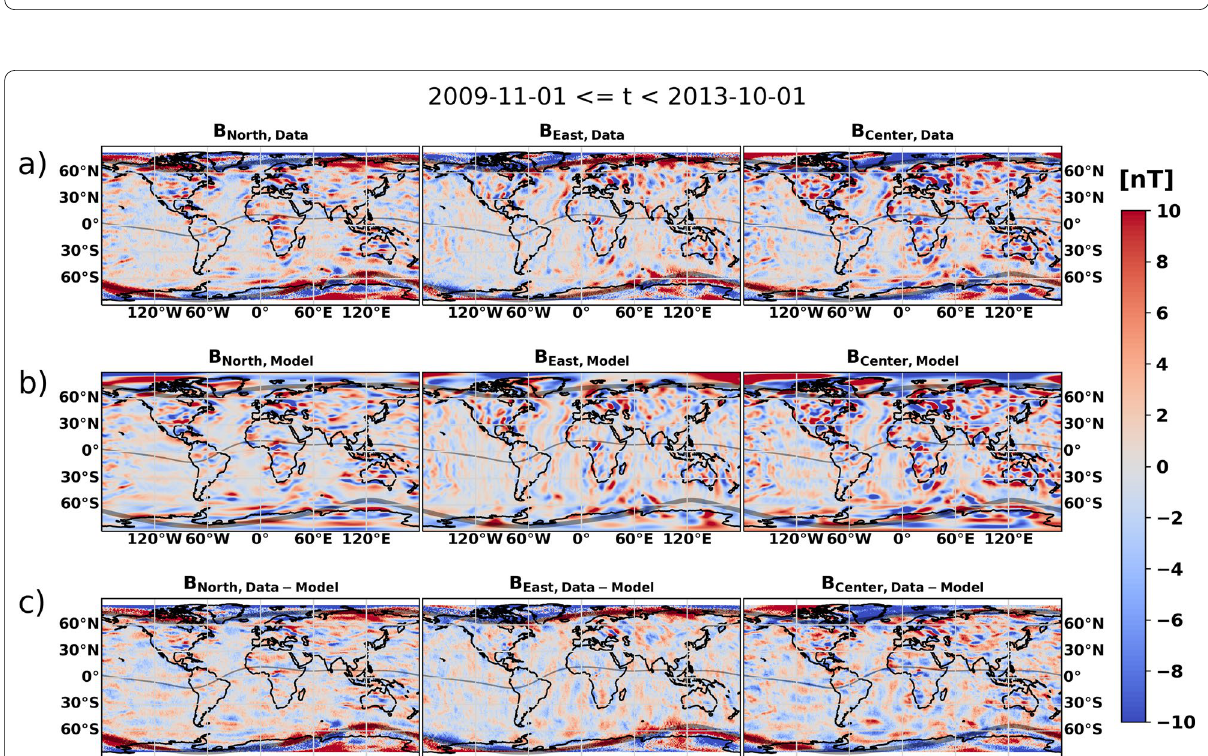
Fig. 10 Lithospheric field residual of GOCE data after subtraction of CHAOS‑7 core and large‑scale magnetospheric field components (top) and high‑resolution lithospheric field model calculated from Thébault et al (2021) (middle). The bottom panel shows the difference between GOCE lithospheric field data and the high‑resolution lithospheric